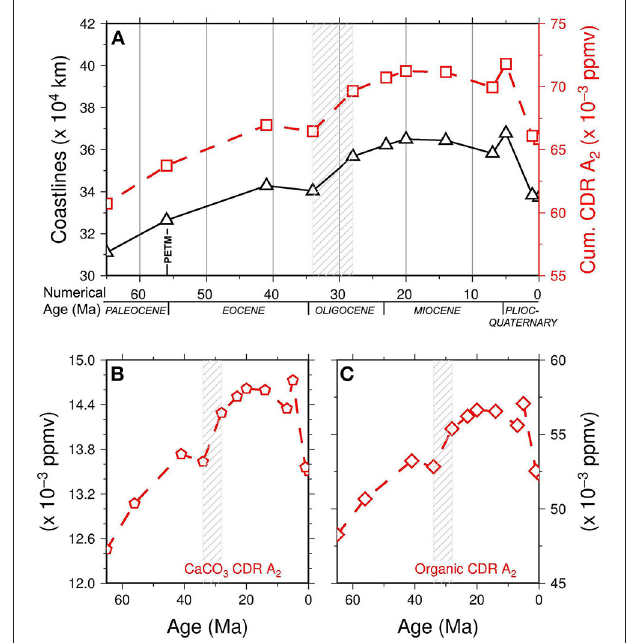
FIGURE 3 | (A) Cenozoic cumulative carbon dioxide removal (CDR) for model A 2 (red line, open squares, compared with variations of coastline length (black line open triangles). (B) Cenozoic inorganic (CaCO 3 ) carbon dioxide removal (CDR) for model A 2 . (C) Cenozoic organic carbon dioxide removal (CDR) for model A 2 . Dashed pattern represents the Eocene-Oligocene time interval. Data are reported in Table